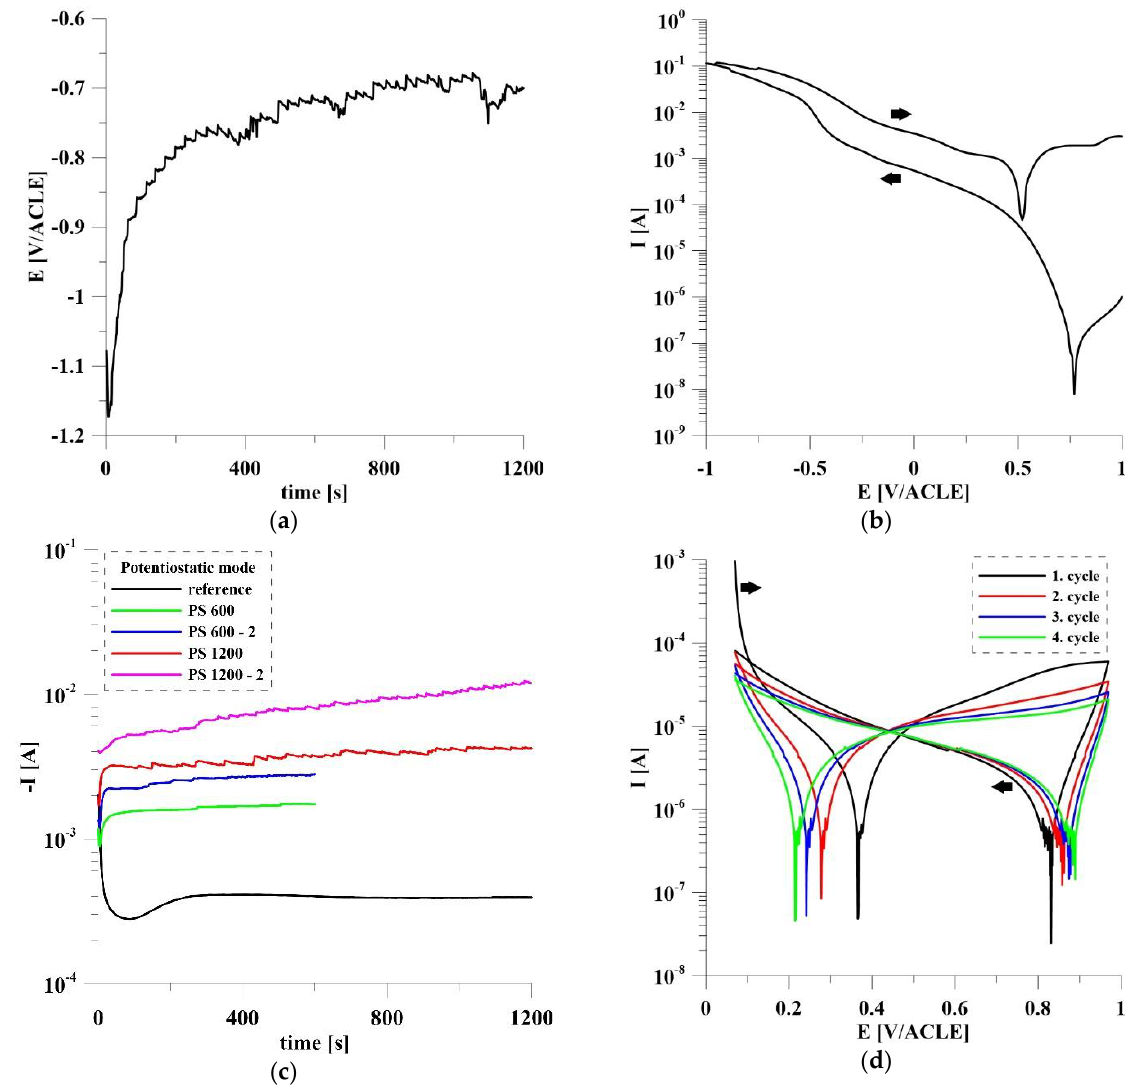
Figure 3. The current and potential dependencies of individual modes of Ru deposition: ( a ) galvanostatic mode ( b ) cyclic polarization; ( c ) potentiostatic mode; ( d ) oxidation of sample PS 1200ox by cyclic polarization in H 2 SO 4 . Table 4. Results of XPS analysis of representative PS 1200 and PS1200ox specimens. Content